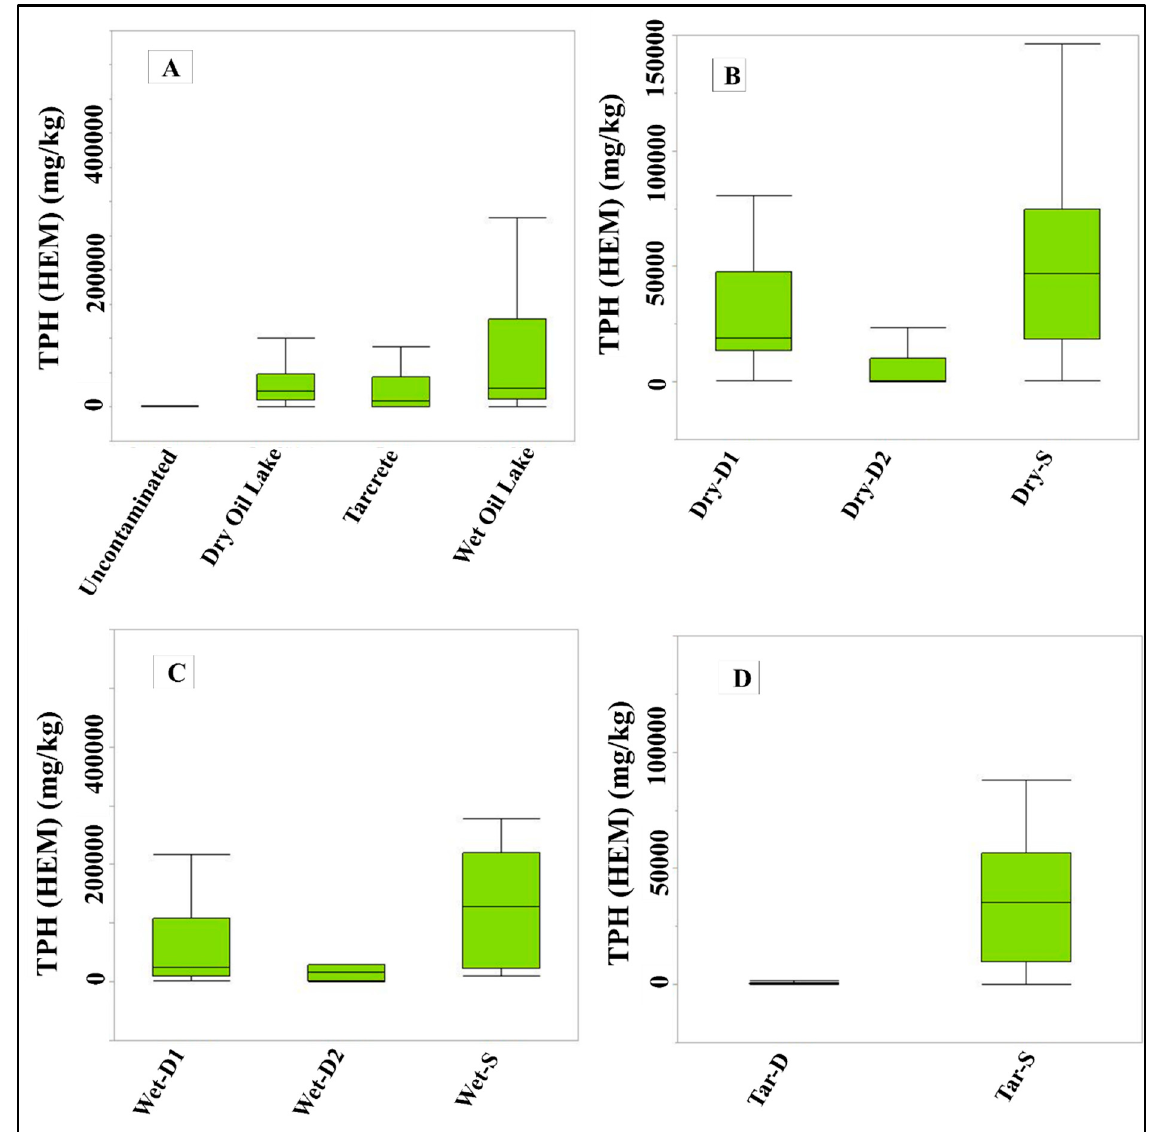
Figure 3. Results of TPH analysis of soil samples for ( A ) all four categories, ( B ) DOL, ( C ) WOL, and ( D ) tarcrete for different soil depths.